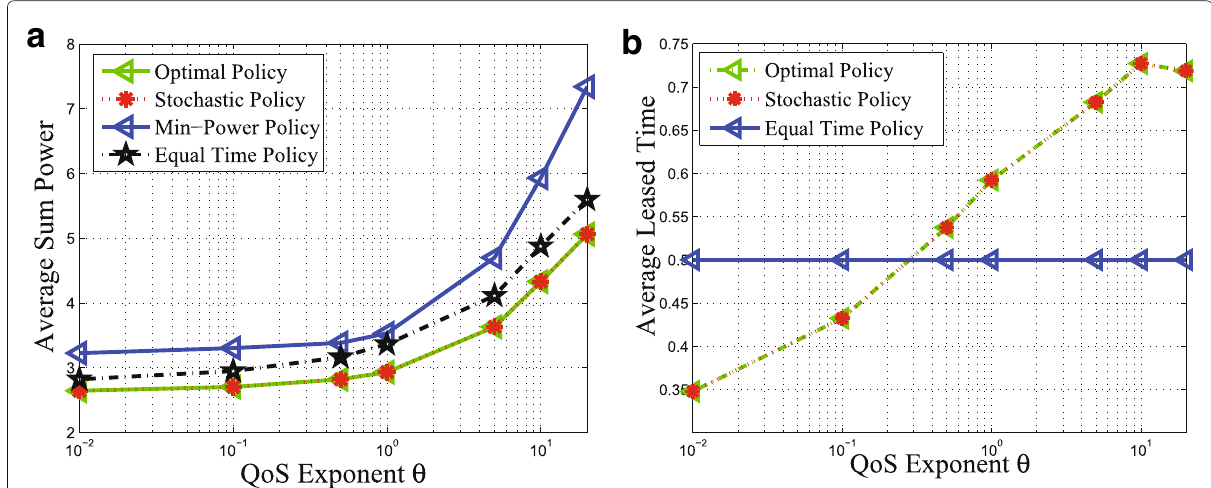
Fig. 4 a , b Average sum power and leased time versus delay QoS exponent θ with AF relay protocol when { ω 1 = 0.5, ω 2 = 0.5 } is adopted